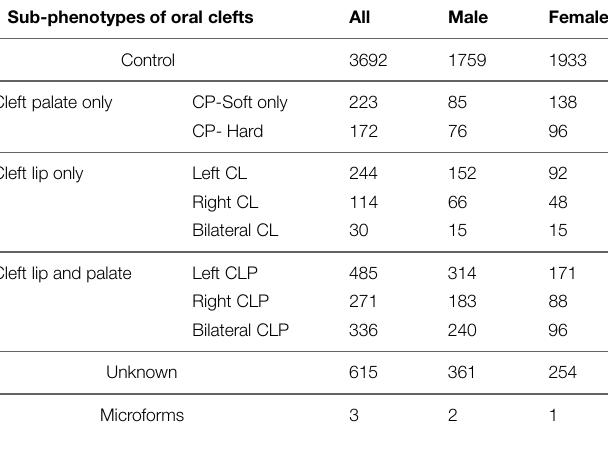
TABLE 1 | Distribution of sub-phenotypes in the Interactions Controlling Oral Clefts (ICOCs) dataset. Sub-phenotypes of oral